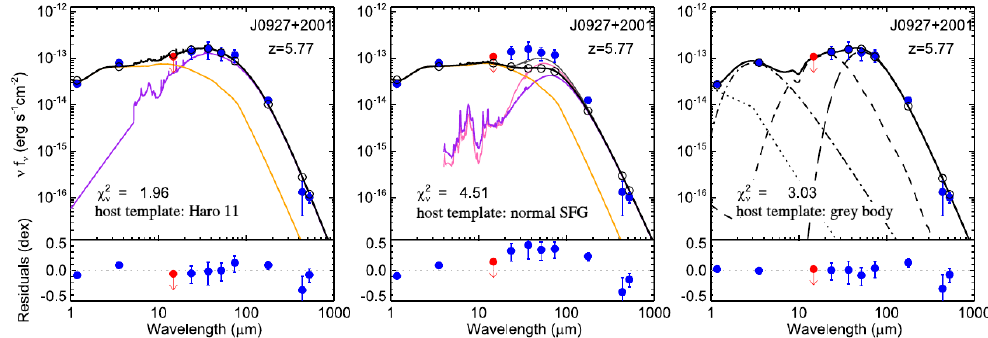
Figure 11. Example SED decomposition of a z ∼ 5.8 quasar. A template based on the local galaxy Haro 11 has been shown to provide a reasonable fit to luminous SFGs at this redshift [186]. The left panel shows the decomposition of Haro 11 + normal AGN template, the middle panel shows the results of a local SFG + normal AGN template (which works well at low- z ), and the right panel is the result from a complicated SED decomposition model used in Leipski et al. [36], where the galaxy IR emission is modeled by a grey body with T = 47 K. The open circles are synthetic photometry performed on the fits, while the blue filled circles are the observed photometry. The Haro 11 fit (left panel) is simpler and equally as accurate as the multi-component one, supporting the hypothesis